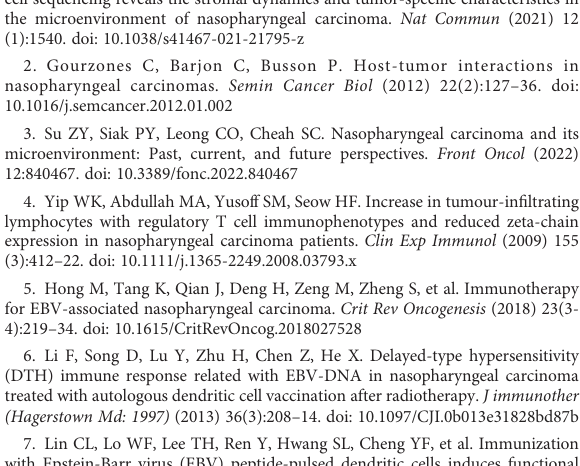
SUPPLEMENTARY FIGURE 1 Cuproptosis related genes for strati fi cation in tumor cell-enriched region and immune cell-enriched region region. (A) NPC patient status distribution (PCA group) in tumor cell-enriched region and immune cell-enriched region. (B) Differential analysis in immune cell-enriched region, green for downregulation, red for upregulation, log|FC|>1 and P<0.05. (C) Univariate Cox analysis in immune cell-enriched region. (D) Principal component analysis in immune cell-enriched region. (E) Survival analysis of genes screened by univariate Cox regression analysis in tumor cell-enriched region and immune cell-enriched region. SUPPLEMENTARY FIGURE 2 Drug sensitivity analysis and the role of Jab1 in different regions of NPC. (A) Differences in IC50 of drugs in NPC patients in tumor cell-enriched region and immune cell-enriched region. (B) Jab1 expression affects the IC50 of drug-treated HNSCC patients. (C) Differential analysis of the Jab1 high and low expression groups in tumor cell-enriched region and immune cell-enriched region. (D) Differential genes from the Jab1 high and low expression groups for survival analysis in tumor cell-enriched region and immune cell-enriched region. (E) Differential genes from the Jab1 high and low expression groups for functional enrichment analysis (GO and KEGG) in immune cell-enriched region. SUPPLEMENTARY FIGURE 3 Effectofcuproptosis relatedgenesonthe survivalofHNSCC patients with different Jab1 expression